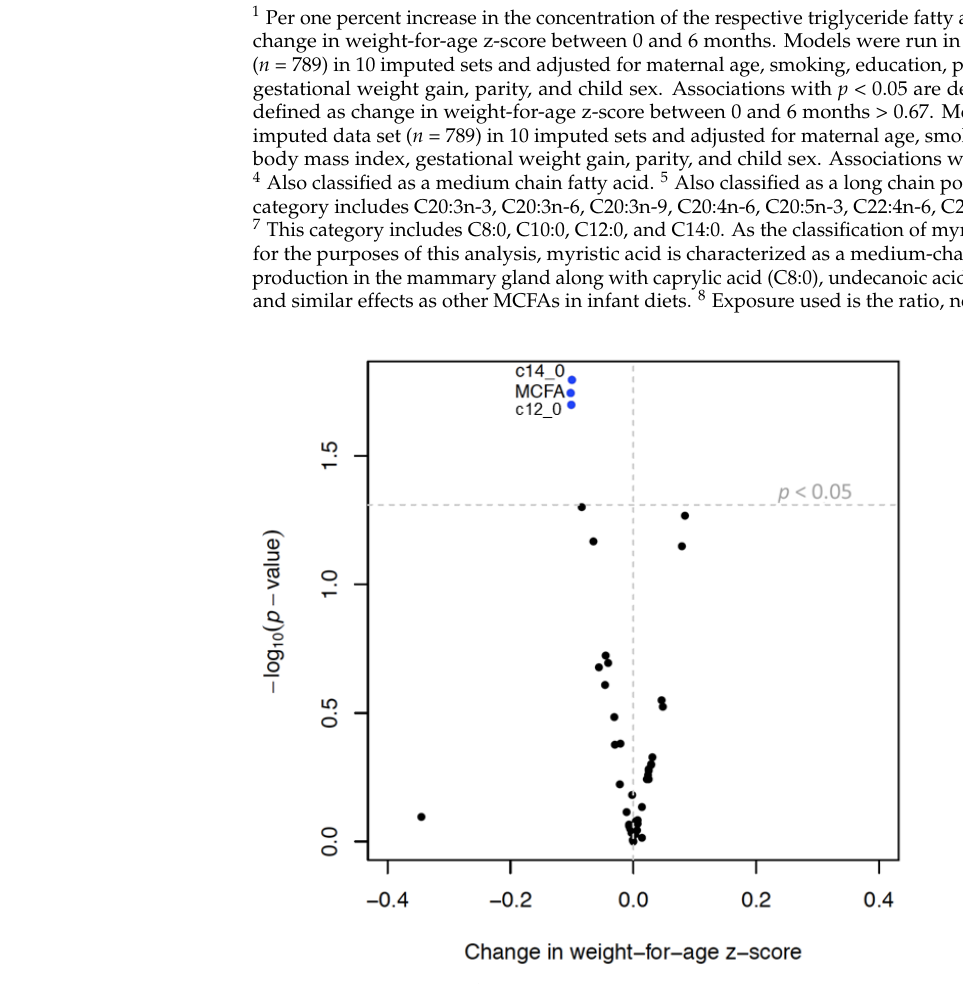
Figure 3. Volcano plot 1 showing associations 2 between triglyceride fatty acid (TGFA) composition in milk and infant growth 3 . Legend: 1 Each dot represents change in weight-for-age z-score (x axis) per interquartile range (IQR) increase in TGFA composition. Y-axis represents the − log 10 of the p value. The vertical dotted line represents a beta coefficient of 0 and the horizontal dotted line repre- sents a p -value of 0.05, so that dots above that line represent associations that have a p -value < 0.05. 2 Models were run in the multiply imputed data set ( n = 789) in 10 imputed sets and adjusted for maternal age, smoking, education, pre-pregnancy body mass index, gestational weight gain, parity, and child sex. 3 Infant growth defined as change in weight-for-age z-score between 0 and 6 months.